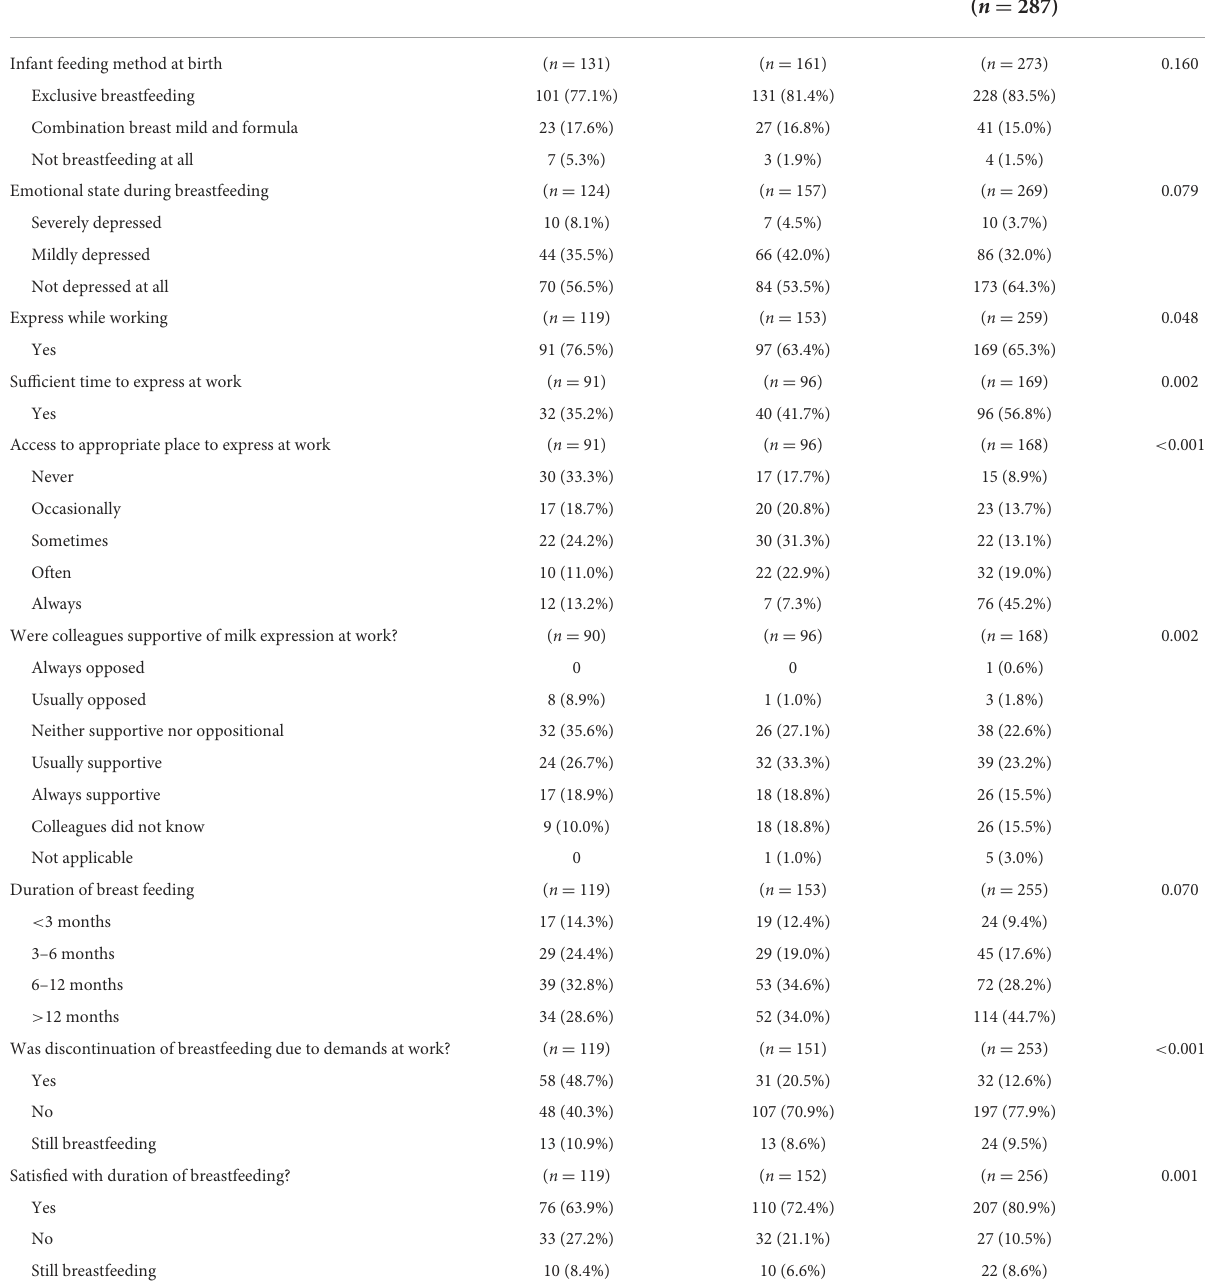
TABLE 5 Breastfeeding practices comparison among